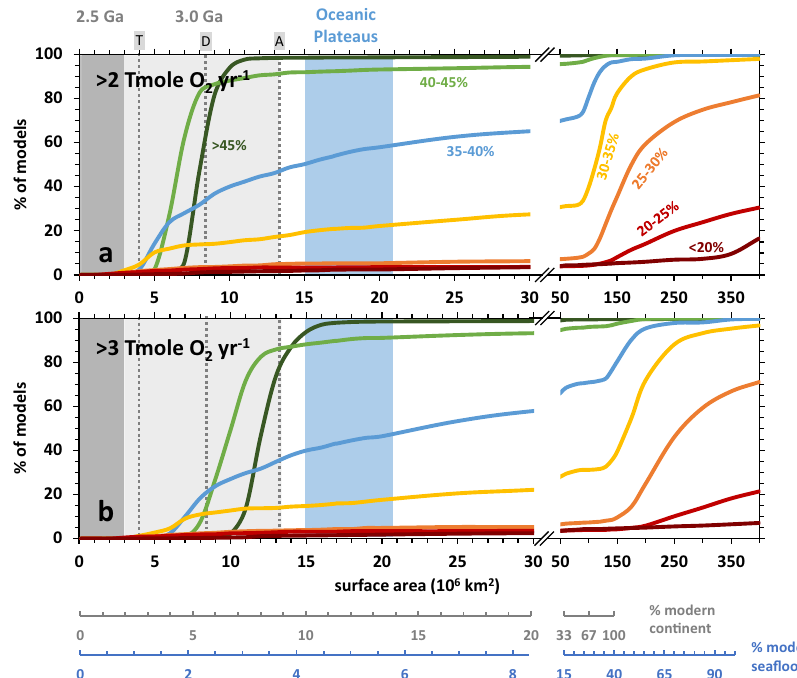
Fig. 4 O 2 consumption vs extents of ultrama fi c rocks. Potentials for consuming more than 2 ( a ) or 3 ( b ) Tmole O 2 yr − 1 as functions of the extent of Fe- bearing rocks exposed in either continents or sea fl oor (in km 2 ). Scales at the bottom compare given values to present-day continents and sea fl oor extents. Results are from models assuming serpentinization rate = 10 -6 kmyr − 1 . Light and dark grey shaded areas depict estimated ranges in the extent of ultrama fi c rocks exposed in continents 3.0 and 2.5 Ga ago, respectively. Vertical dashed grey lines depict maximum extent of ultrama fi c or komatiite exposures at 3.0 Ga based on compositional estimates of Greber et al. 53 and continental growth models of (A) Armstrong 63 , (D) Dhuime et al. 56 , and (T) Taylor and McLennan 65 . Other continental growth models 64,66 yields much lower maximum ultrama fi c extents. The blue shaded area represents the extent of oceanic plateaus at the present-day (~4 – 6% of the sea fl oor) 71 . Curves of various colors depict the results of models simulating rocks belonging to different compositional groups as indicated by the MgO